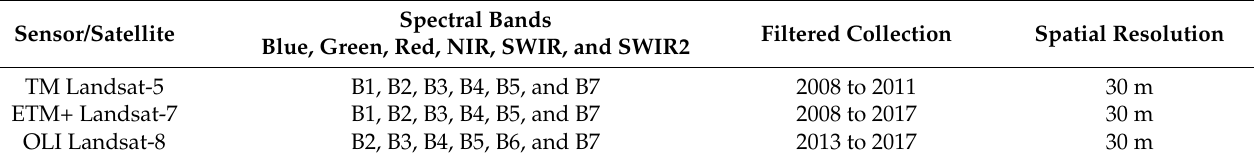
Table 2. Description and temporal coverage of spectral information of the different bands and sensors used. Spectral Bands Filtered Collection Spatial Resolution Sensor/Satellite Blue, Green, Red, NIR, SWIR, and SWIR2 TM Landsat-5 B1, B2, B3, B4, B5, and B7 2008 to 2011 30 m ETM+ Landsat-7 B1, B2, B3, B4, B5, and B7 2008 to 2017 30 m OLI Landsat-8 B2, B3, B4, B5, B6, and B7 2013 to 2017 30